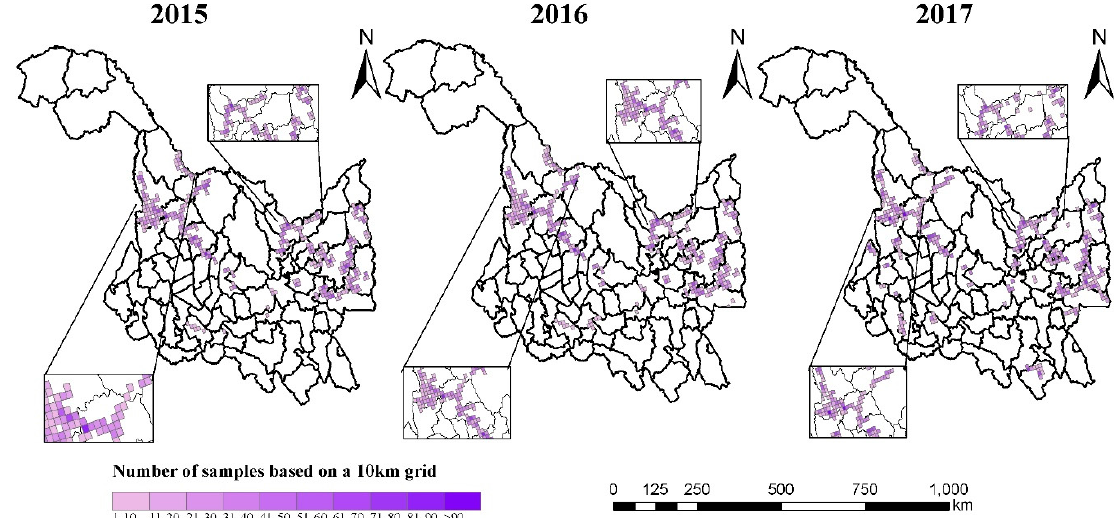
Figure 6. Graph showing how many samples per grid in each year after the three-year sample of Heilongjiang Province was entered into the RDCRMG. Grids from the blank areas do not contain samples. The color depth indicates the number of samples, and each grid has a maximum of 91 samples.